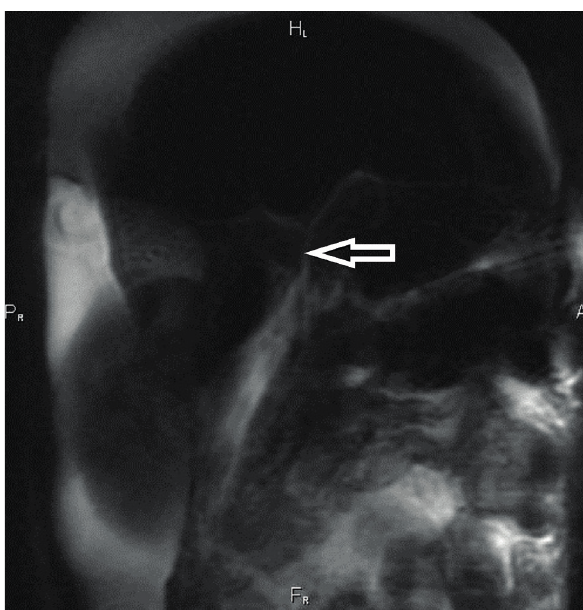
Fig. 2. MRCP + MR enterography without maghemite contrast agent, (after PEG bowel preparation): 52-year-old woman before liver transplantation having liver cirrhosis, due to hepatitis C. Presence of advanced ascites and edema of bowel wall; arrow depicts a delineation of extrahepatic biliary ducts.